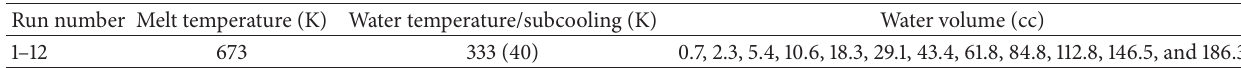
Figure 7: Analytical geometry. Table 3: Conditions of calculated